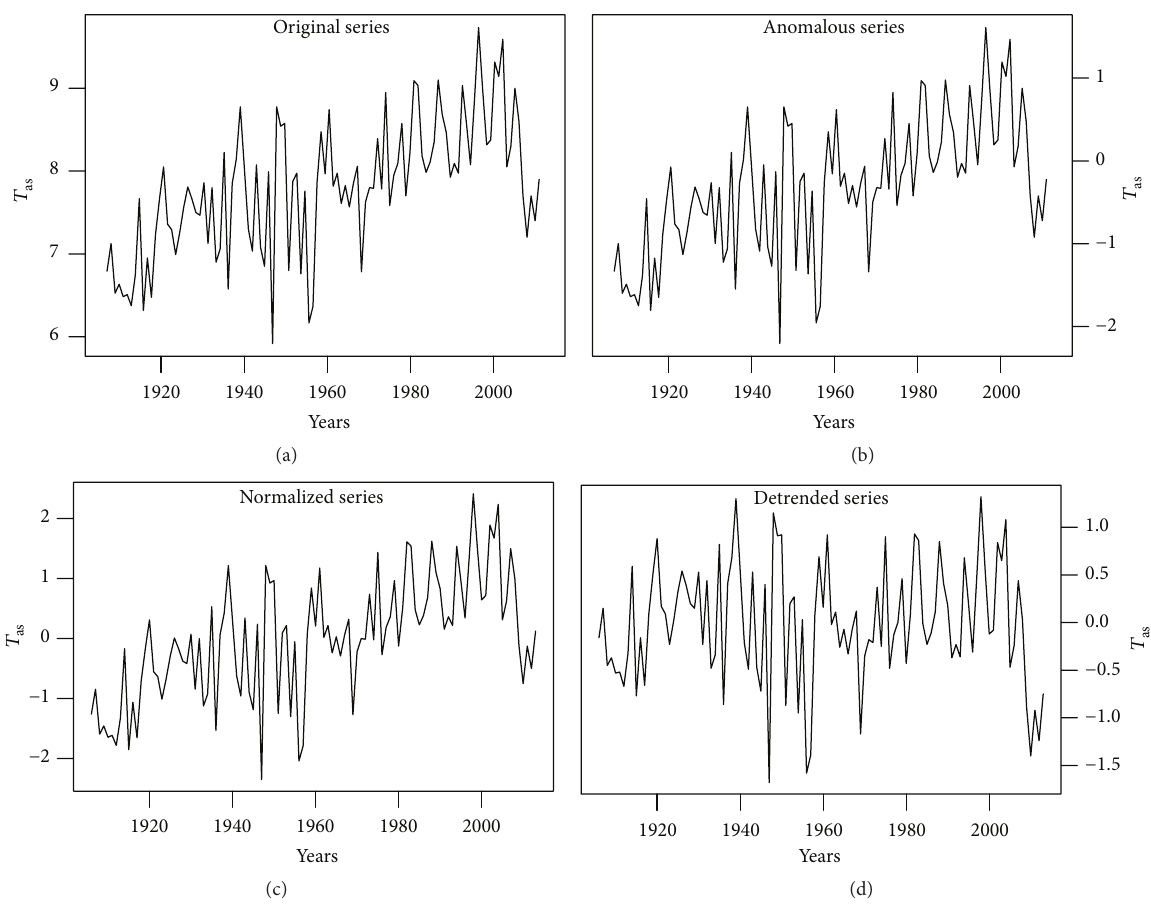
Figure 6: Time series of temperature data from the Shenyang station from 1906 to 2013: (a) original series, (b) anomalous series, (c) normalized series, and (d) detrended